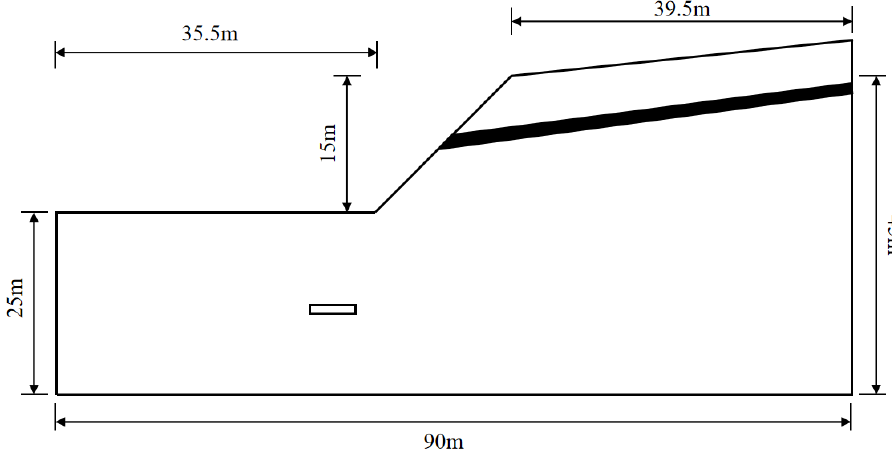
Figure 3. Schematic diagram of the model size.